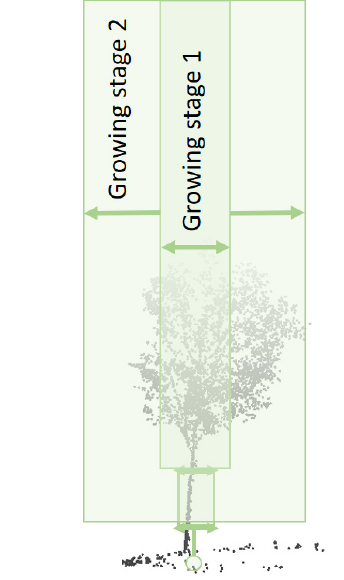
Figure 4. Growing phase after seed selection, first vertically for poles and trees, then